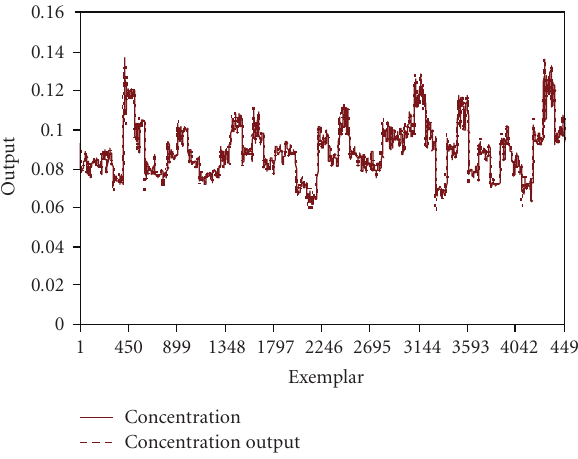
Figure 7: Desired output and Network output for testing data set (Fully recurrent NN model-Benchmark